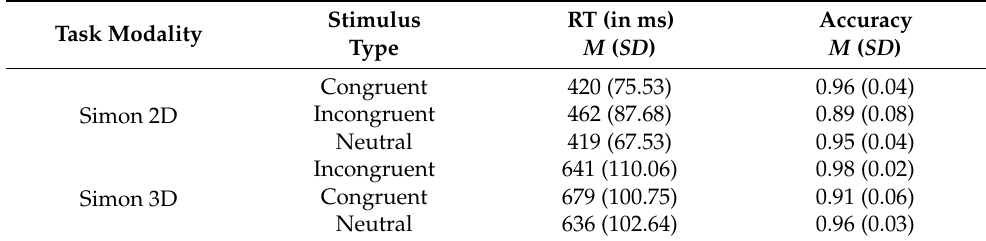
Table 1. Mean accuracy proportions and reaction time (RT) results per condition, task modality, and task. Standard deviation is presented in